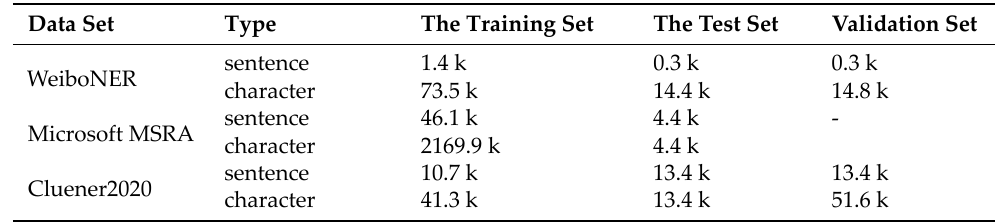
Table 1. Experiment data